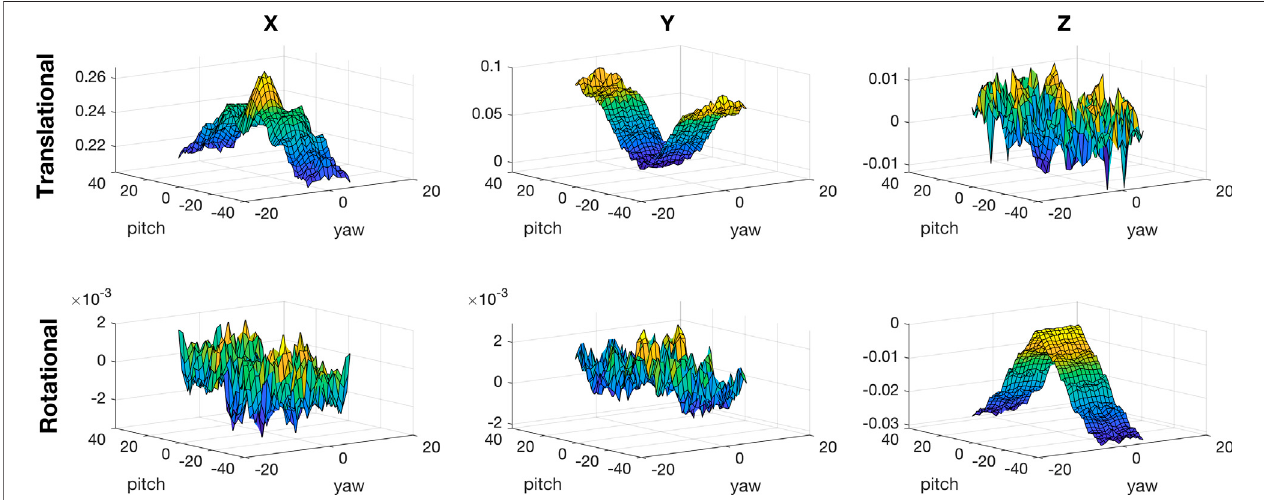
FIGURE 4 | Drag force computed using computational fl uid dynamics software. Since they are based on air fl ow with unit velocity, the drag coef fi cient and drag force can be calculated using them. The X-axis directs the heading direction, the Y-axis lateral, and the Z-axis vertical.